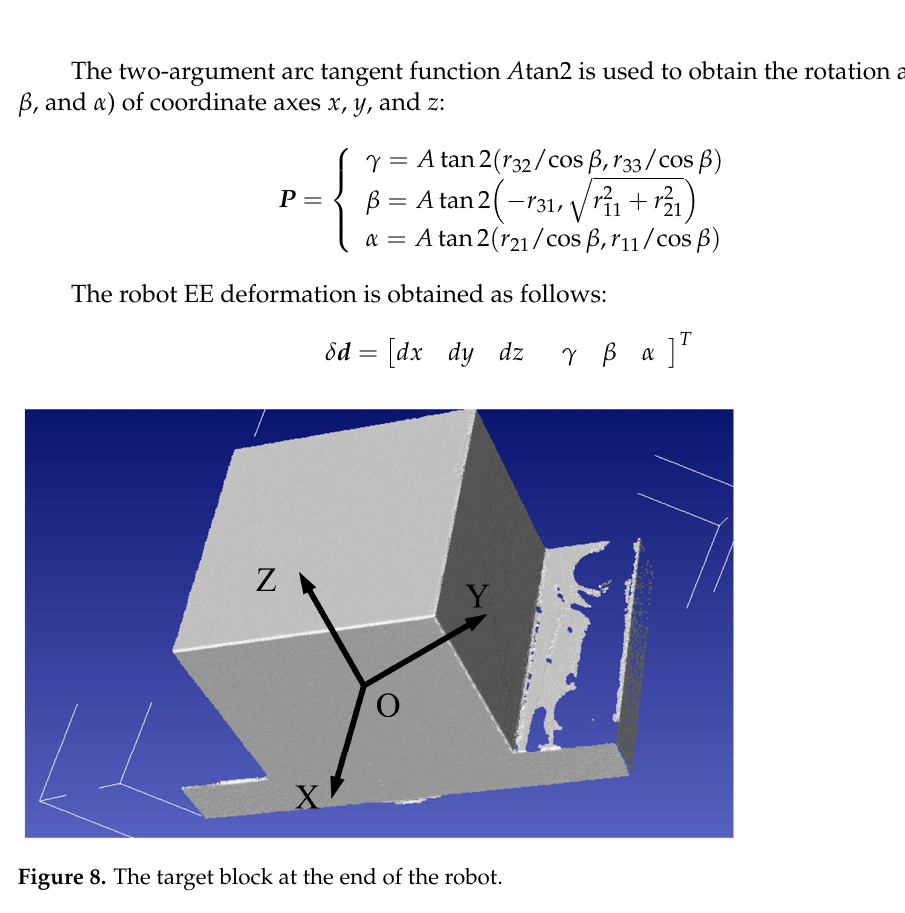
Figure 7. Procedure for obtaining the EE displacement.